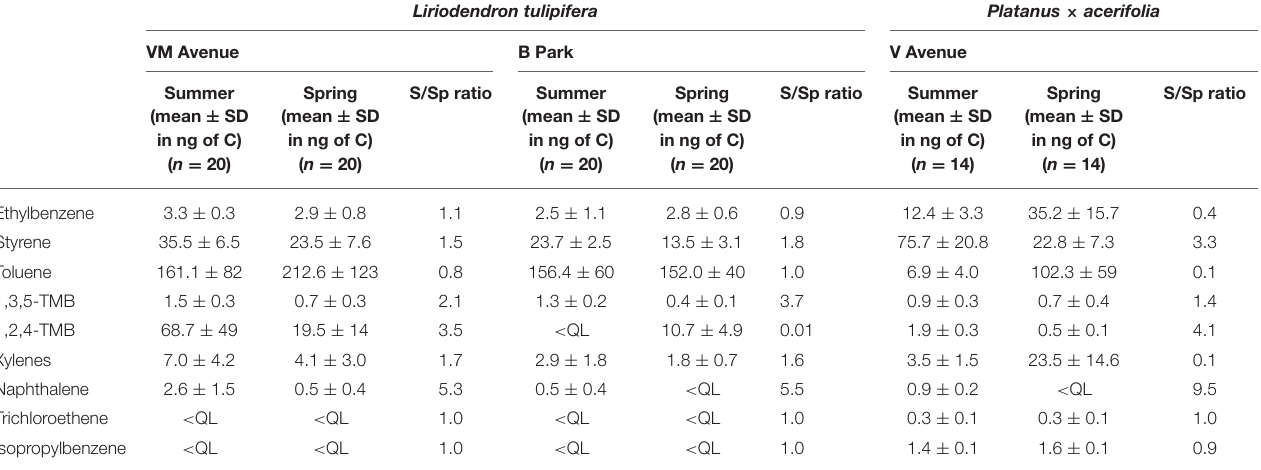
TABLE 1 | Seasonal variability of selected AVOCs at the three sampling sites (VM Avenue, V Avenue, and B